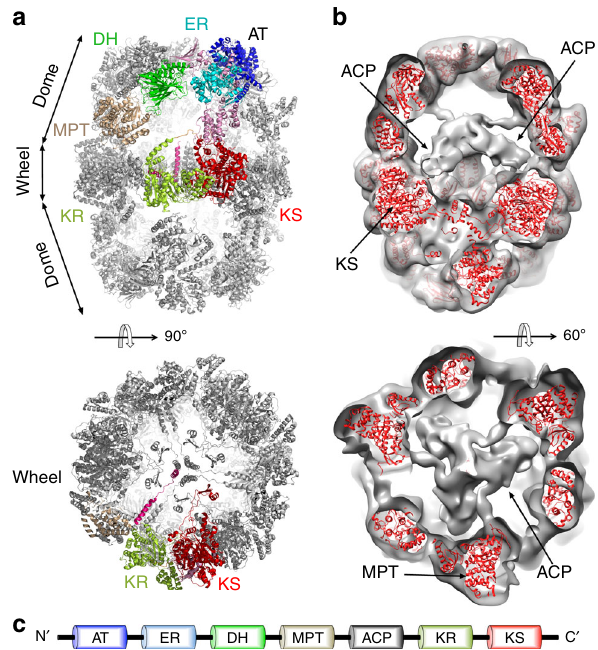
Fig. 2 Structure of the Mtb FAS-I. a The fi nal model of Mtb FAS-I is shown using ribbon representation. A ‘ side ’ view (upper image) reveals the barrel- like shape of FAS-I. One of the six chains that compose the D3-symmetric barrel is colored. Each of the six different catalytic domains that make the barrel is shown using a distinct color: acetyltransferase (AT) in blue, enoyl reductase (ER) in cyan, dehydratase (DH) in green, malonyl transacylase (MPT) in brown, ketoacyl reductase (KR) in light green, and ketoacyl synthase (KS) in red. A ‘ top ’ view (lower image) shows the wheel-like organization of the KR and KS domains. b The Mtb FAS-I model as red ribbon is shown inside a low-pass fi ltered map from one speci fi c 3D class as ‘ tilted ’ and ‘ top ’ views (upper and lower images, respectively). A density for the acyl carrier protein (ACP) is visible. c A schematic diagram showing the domain organization of Mtb FAS-I. Color coding and abbreviations are the same as in